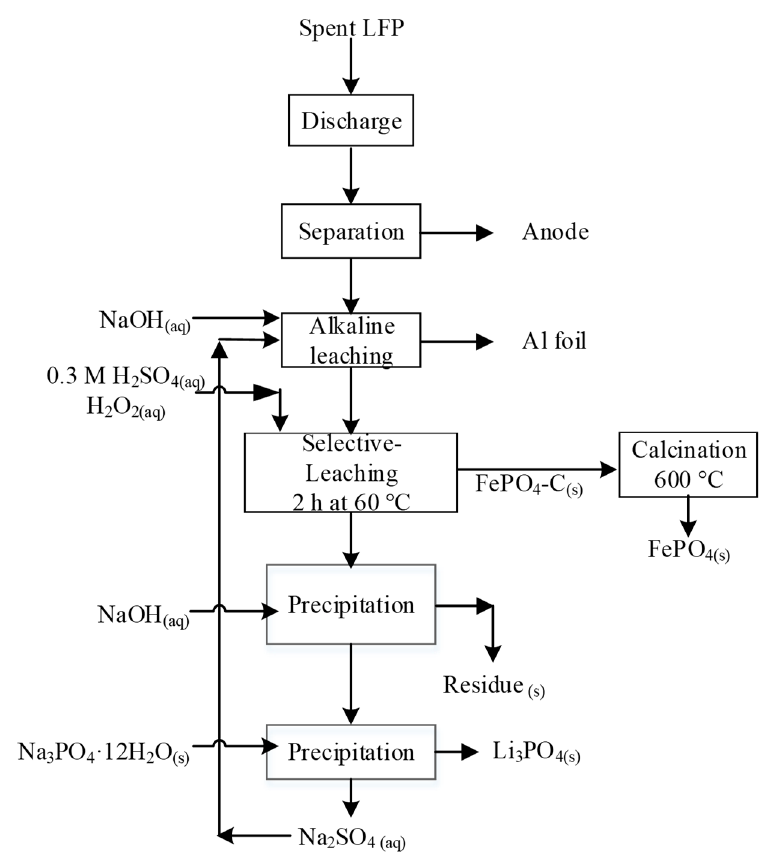
Figure 9. Selective leaching process proposed by Li et al. (according to [123]); here, LFP is LiFePO 4.